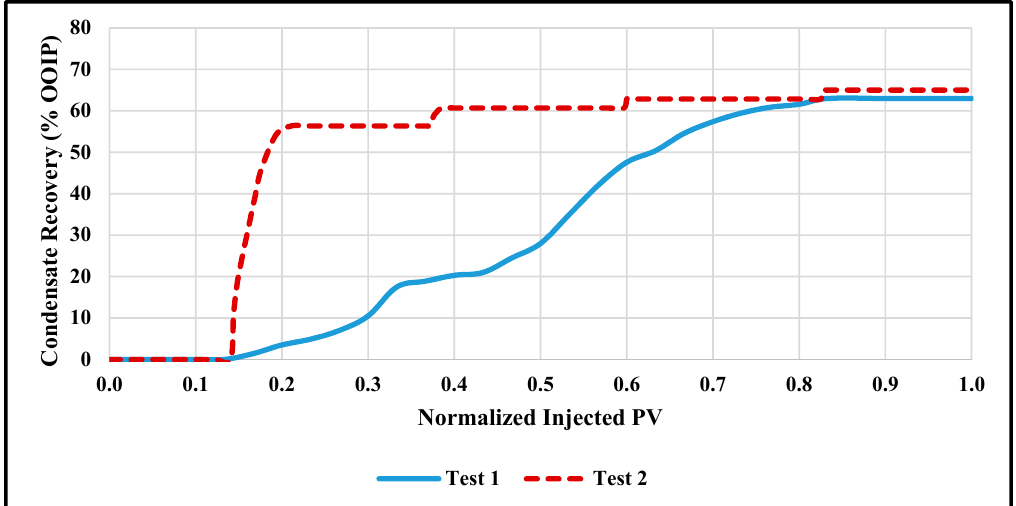
Figure 6. Condensate recovery using continuous injection of thermochemical ( Test 1 ) and huff and puff mode ( Test 2 ).